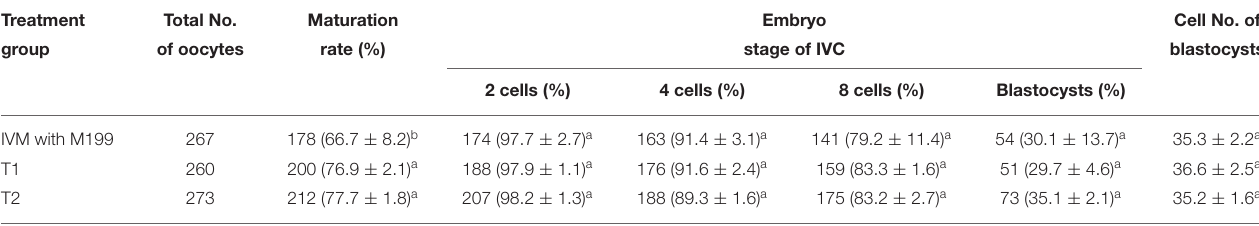
TABLE 1 | Effects of IVM media supplemented with PFTSCs CM on the development of parthenogenetic activation porcine embryos. Treatment Total No. Embryo Cell No. of